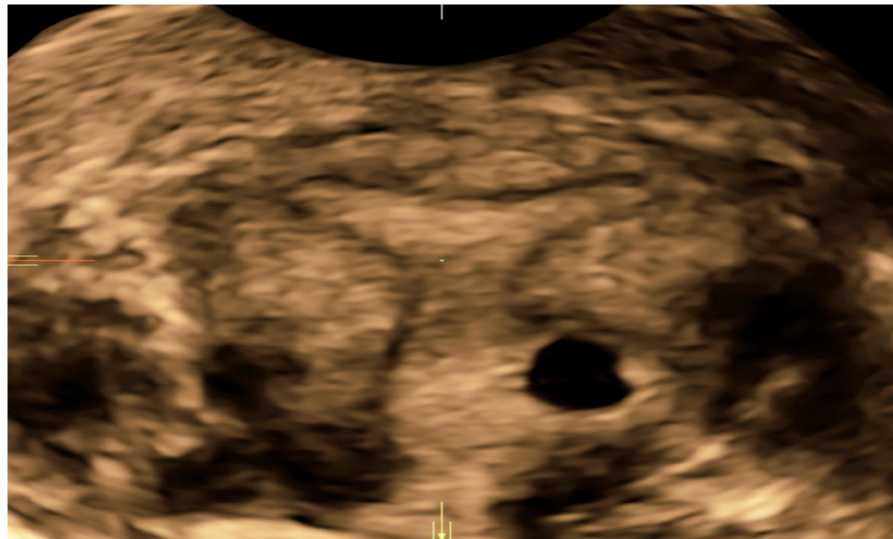
Figure 2. 3D Volume contrasting imaging (VCI) image of a cervical ectopic pregnancy. No evidence of intrauterine pregnancy, hourglass shape of uterus, cervical ballooning, presence of placental tissue or gestational sac within the cervical canal and closed internal uterine orifice. Diagnosis of IP was made by TVUS according to criteria outlined by Timor-Tritsch that consist of an empty uterine cavity, a myometrial layer of less than 5 mm surrounding the GS and a chorionic sac separated and laterally located 1 cm or more from the sideward portion of the uterine cavity [9]. Moreover, the visualization of the interstitial line between the GS and the lateral edge of the endometrial cavity and the myometrial mantle around the ectopic sac helped for diagnosis [10] (Figure 3).